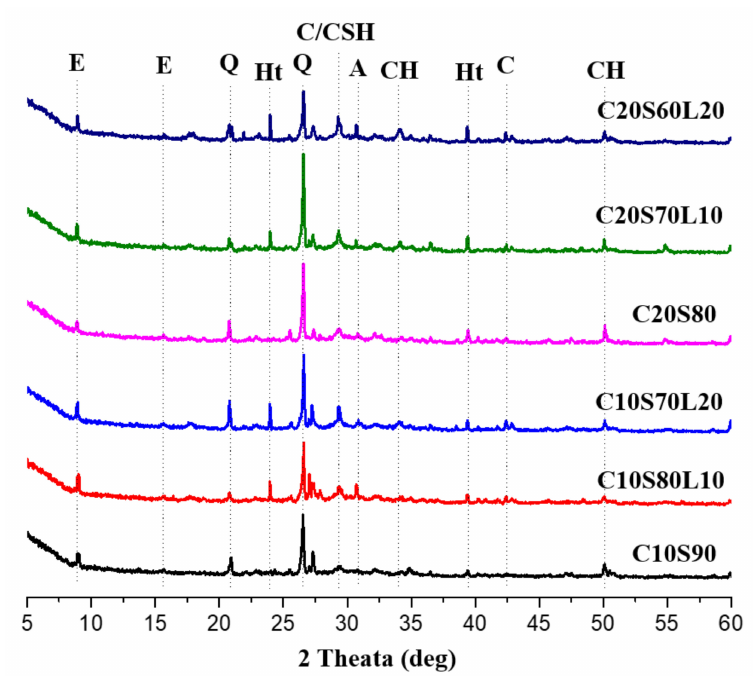
Figure 10. XRD patterns of AAS mixtures with di ff erent OPC and LBD content at 7